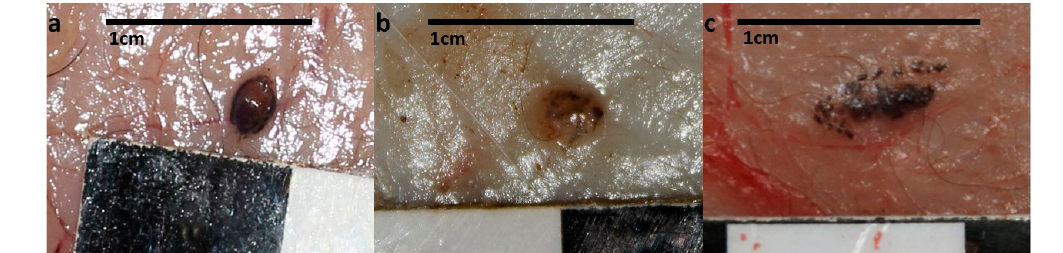
Figure 1. Macroscopic view of ticks with subcutaneous localization at various degradation stages. Well preserved I. ricinus in dorsal position with intact idiosoma ( a ), tick in early decomposition, the body is partially preserved, although not identifiable, and the appendix are not present ( b ), tick in advanced decomposition stage, with fragmented particles of the body ( c ).